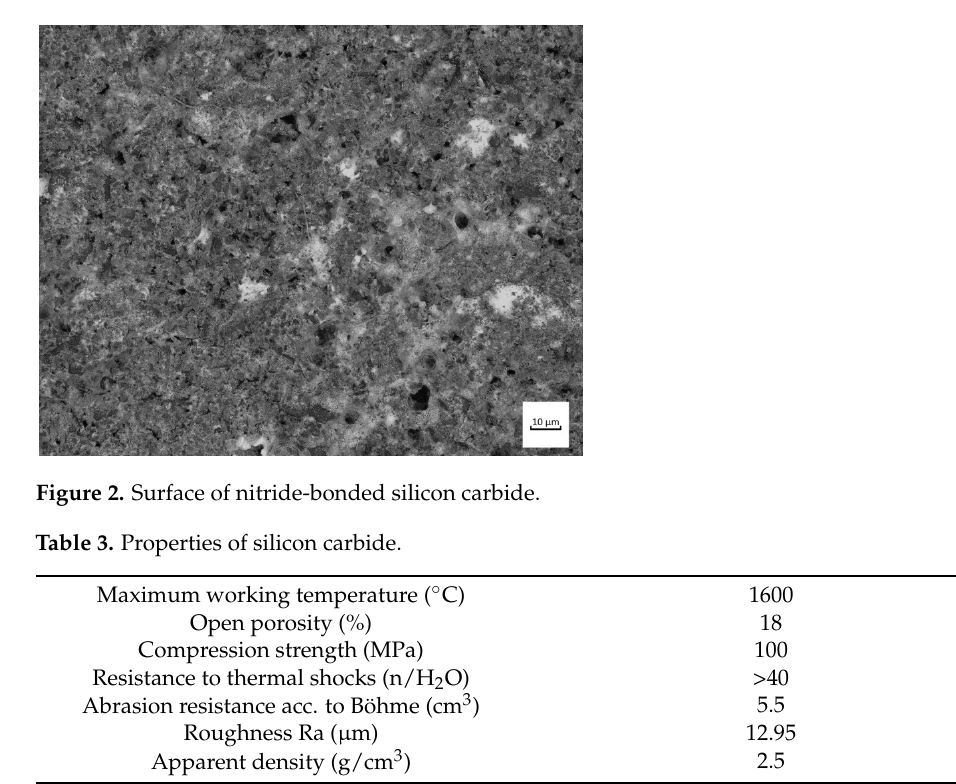
Figure 4. B27 steel microstructure—semi-martensitic with fine carbide grains. Magnitude ×1000, etched with 3% HNO 3 (Mi1Fe), scanning microscopy. A padded layer applied onto machine part surfaces, bound to the macro- and microstructure are one of the main trends in improving the abrasive wear resistance in a soil mass. An analysis of the equilibrium graphs and studies of the phase structure and padded weld microstructure was the starting point for the study. The padded layer was obtained by applying on 38 GSA low-alloy martensitic steel (Figure 5) a coated electrode made of Fe–Cr–C alloys with an addition of niobium (chemical composition of the first layer) (Table 4) with the welding current set at 100 A. The carbon content was 5.2%, chromium content—29%. Chemical composition of 38 GSA steel: C—0.38, Mn—1.12, Cr— 0.15, Si—0.85, P—0.11, Ti—0.09, Al—0.04. Figure 5. 38GSA steel microstructure—fine dispersed perlite with grains of ferrite and martensite. Magnitude 500×, etched with 3% HNO 3 (Mi1Fe).